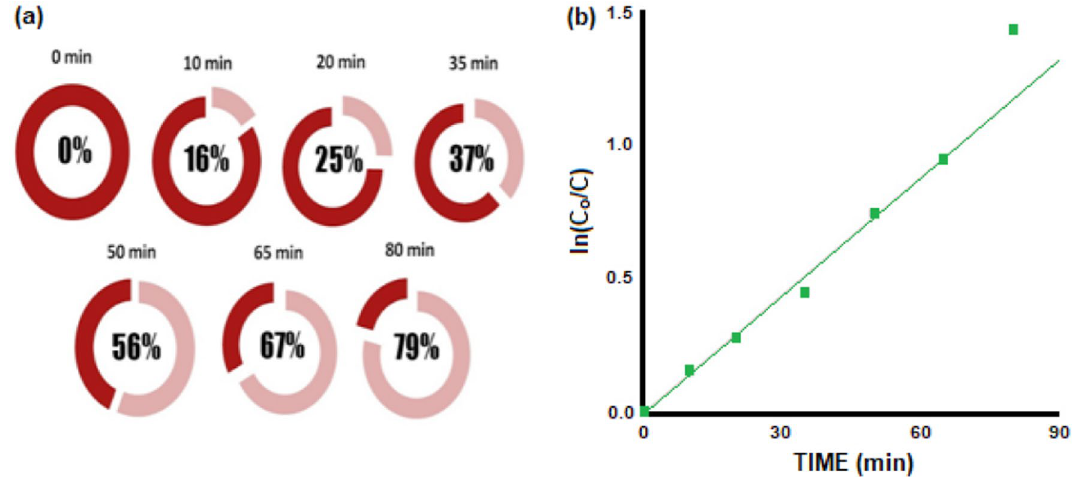
Figure 5. ( a ) Percentage degradation of Azo Dye AR183 with ZNsw versus Irradiation time (min −1 ) and ( b ) Pseudo-First order kinetics based upon Langmuir–Hinshelwood (L–H) kinetic treatment model for Azo Dye AR183 photodegradation in the presence of photocatalyst